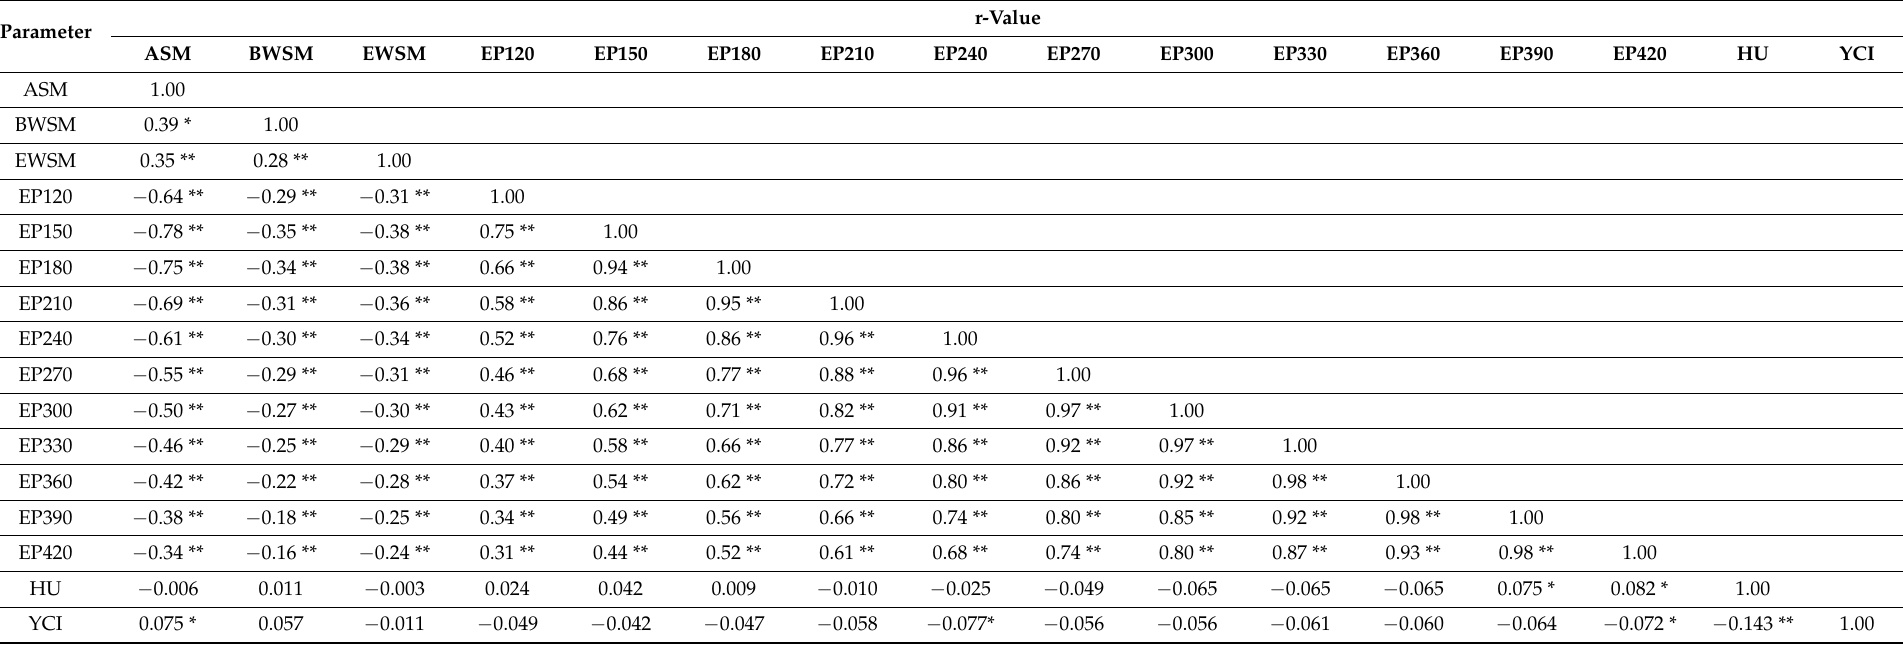
Table A2. r-Value Results of Correlation Analysis between Reproductive Parameters and Egg